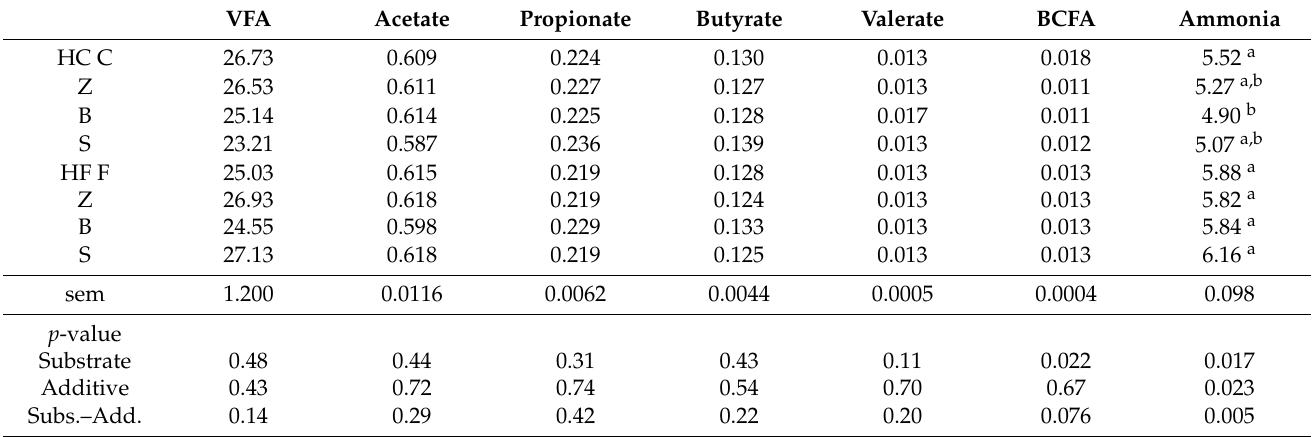
added to HF but not to HC (substrate–additive interaction, p = 0.076). At 12 h of incubation (Table 5), no treatment differences were detected in the total VFA concentration, but higher proportions of acetate (0.571 vs. 0.552; p = 0.032) and BCFA (0.0148 vs. 0.0128; p = 0.013) at the expense of butyrate (0.136 vs. 0.144; p = 0.028) were found in HF compared with HC. Between the substrates, the ammonia concentration was lower ( p = 0.017) with HC at 6 h (5.19 vs. 5.93 mM; sem = 0.108), and differences tended towards significance ( p = 0.050) at 12 h (7.25 vs. 7.93 mM; sem = 0.151). With HC as the substrate, the inclusion of B reduced the ammonia concentration compared to C at both 6 and 12 h incubation, but no differences between the additives were recorded with HF. Table 4. Average total concentration (mM) and molar proportions (mmol/mmol) of volatile fatty acids (VFA) and ammonia concentration (mM) recorded at 6 h from a 65:35 (HC) or a 35:65 (HF) concentrate-to-forage substrate, alone (C, F) or supplemented with 10 mg/g of clay minerals (zeolite, Z; bentonite, B; or sepiolite, S).